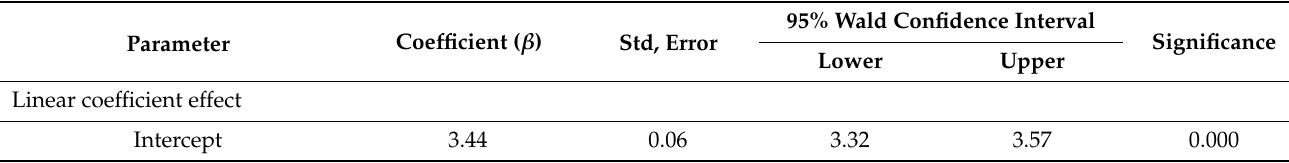
Table 7. The generalized linear model for the effects of L. mesenteroides P. pentosaceus and E. gallinarum and their interaction on the pH of pearl millet